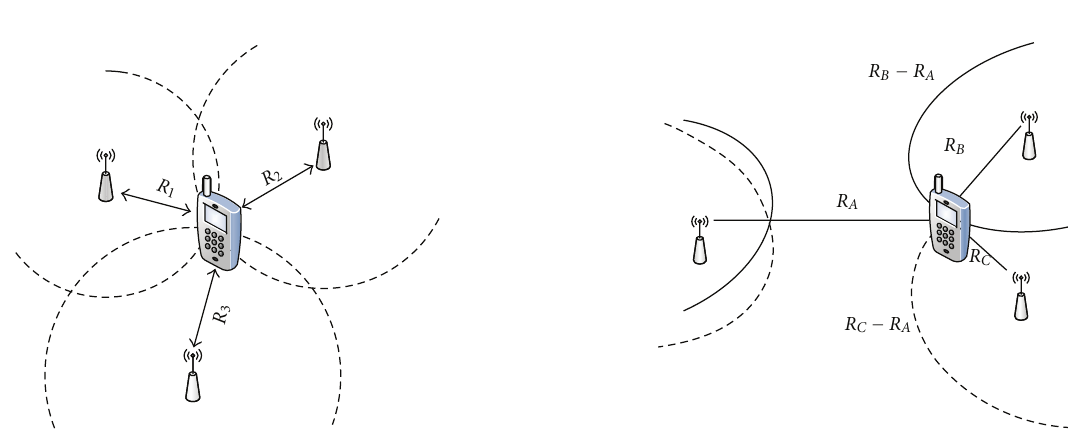
Figure 3: TDoA localization technique